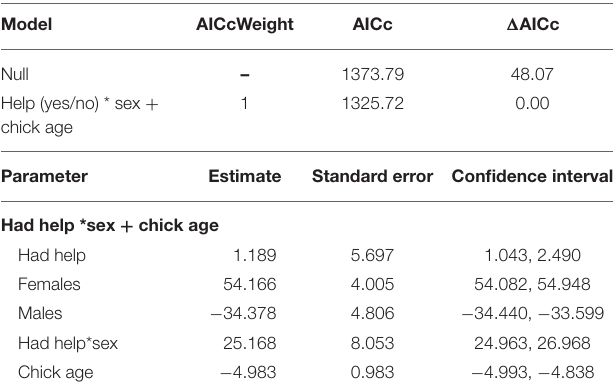
TABLE 4 | The top set of models investigating the factors influencing how much time parents spent with their offspring (for full set of candidate models tested see Supplementary Material S6 ).